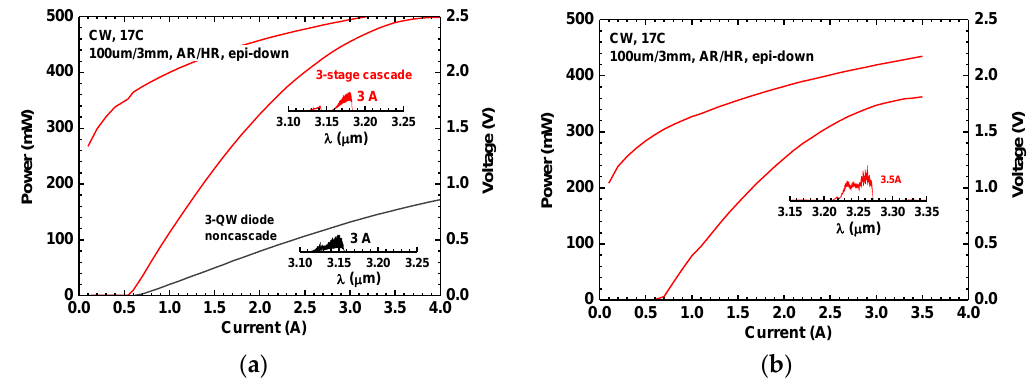
Figure 2. CW light-current characteristics measured at 17 °C for 100-μm-wide, 3-mm-long, coated three-stage cascade diode lasers emitting at ( a ) λ ~ 3.15–3.2 μm [15], and data for reference non-cascade diode laser is also shown; ( b ) λ ~ 3.25 μm. Inserts show the device’s emission spectra.